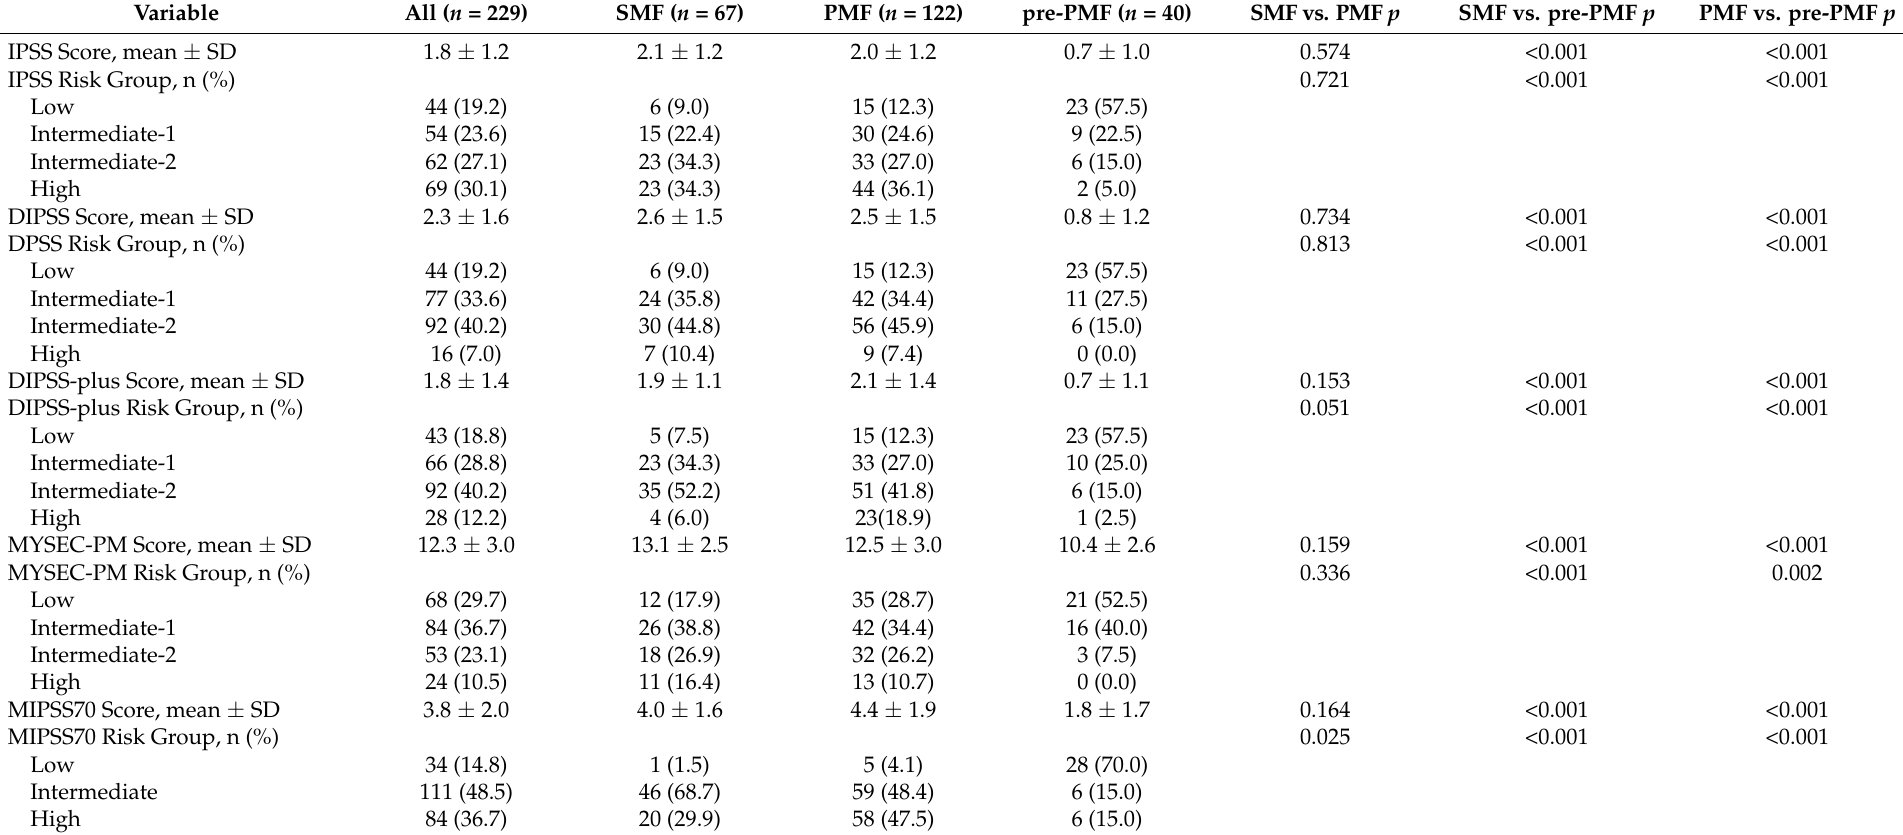
Table 2. Scores of risk stratification in patients with